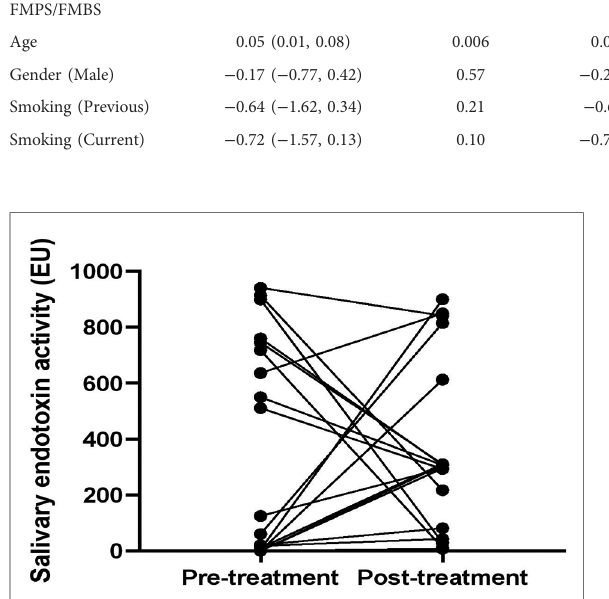
FIGURE 6 The ROC curves of subgingival endotoxin activity for detection of healthy and diseased sites and salivary endotoxin activity as a periodontal biomarker for detecting periodontal health and